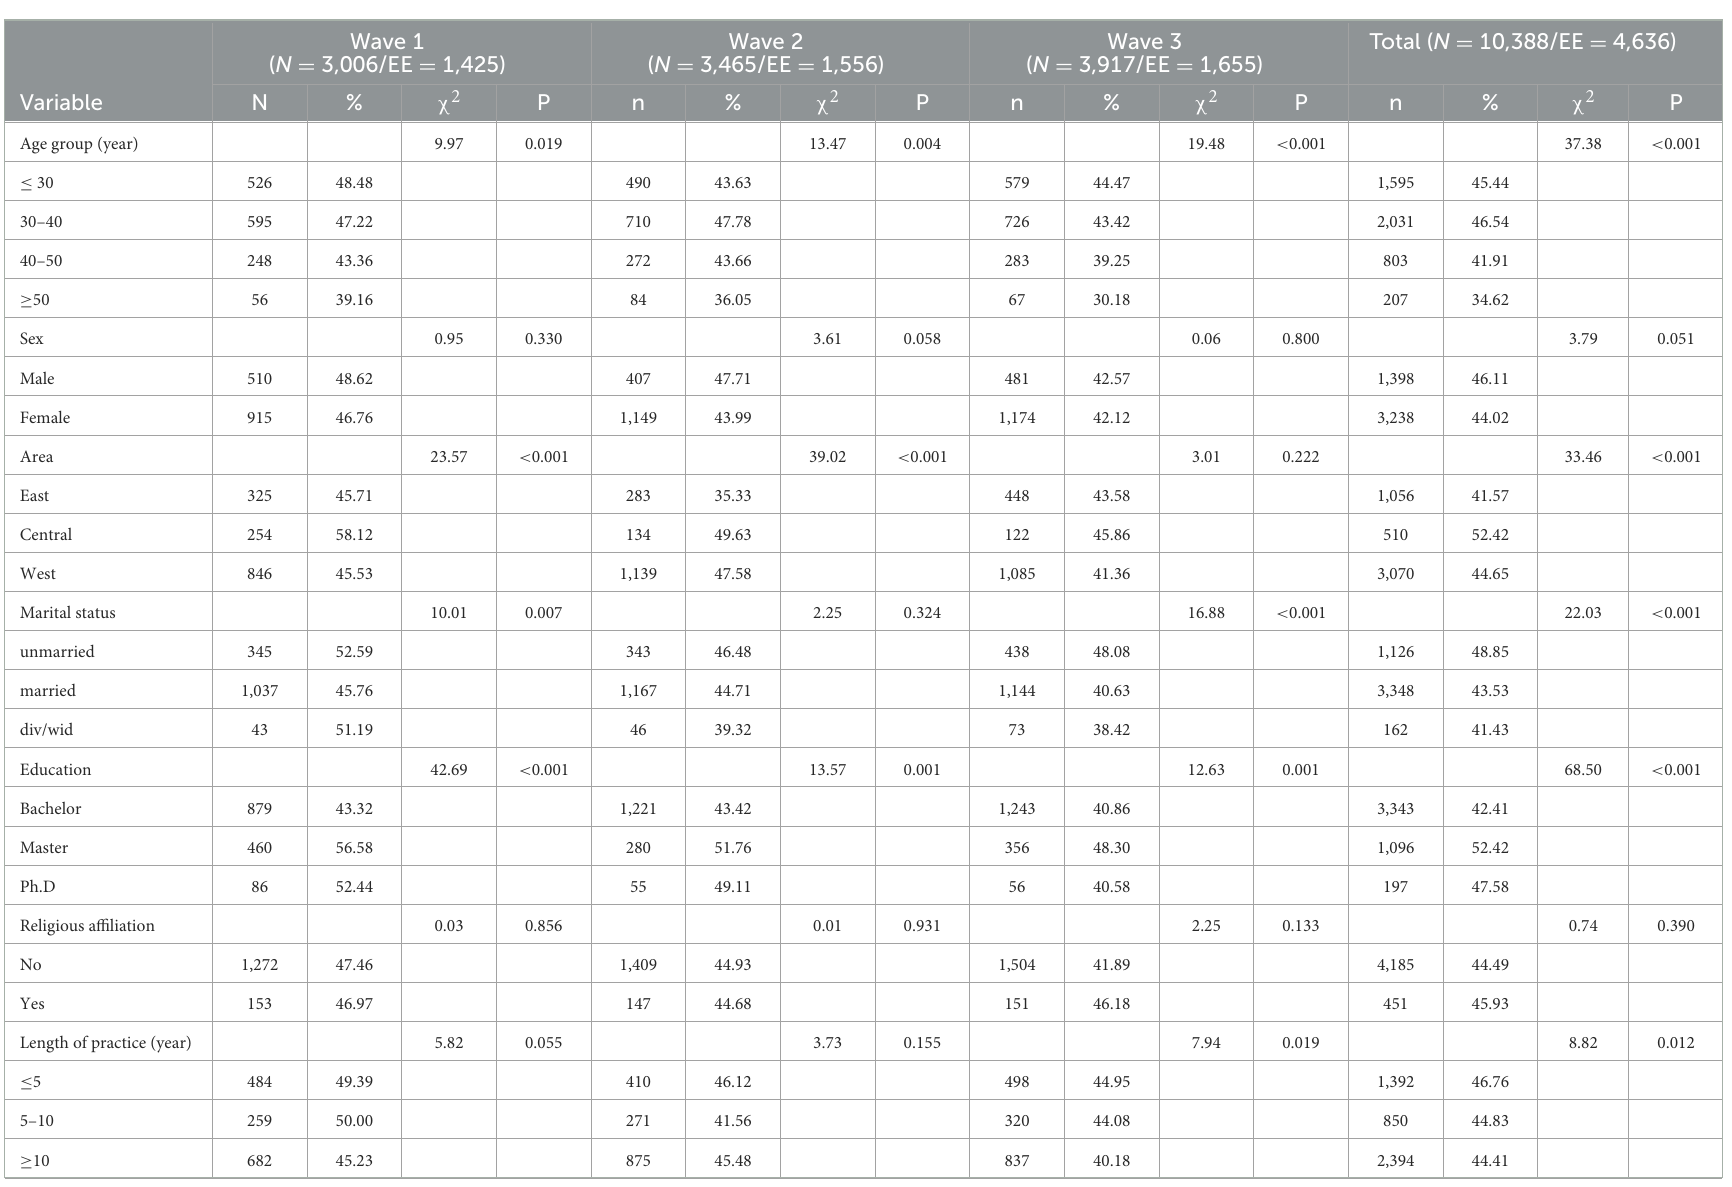
TABLE 1 Epidemiological distribution of the prevalence of emotional